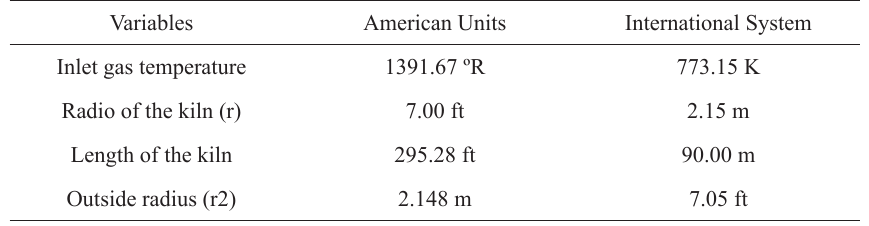
Rotary kiln data reported by industry.